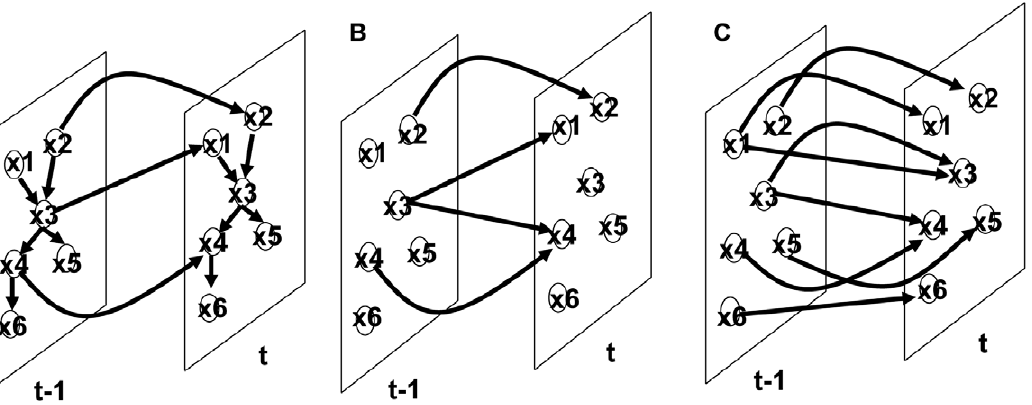
Figure 1. Dynamic Bayesian models under different assumptions. (A) a general two-slice model: a DBN under first-order Markov assumption; (B) a simplified two-slice model assuming no intra-slice interactions; (C) a two-slice model assuming that every variable is under self regulation.